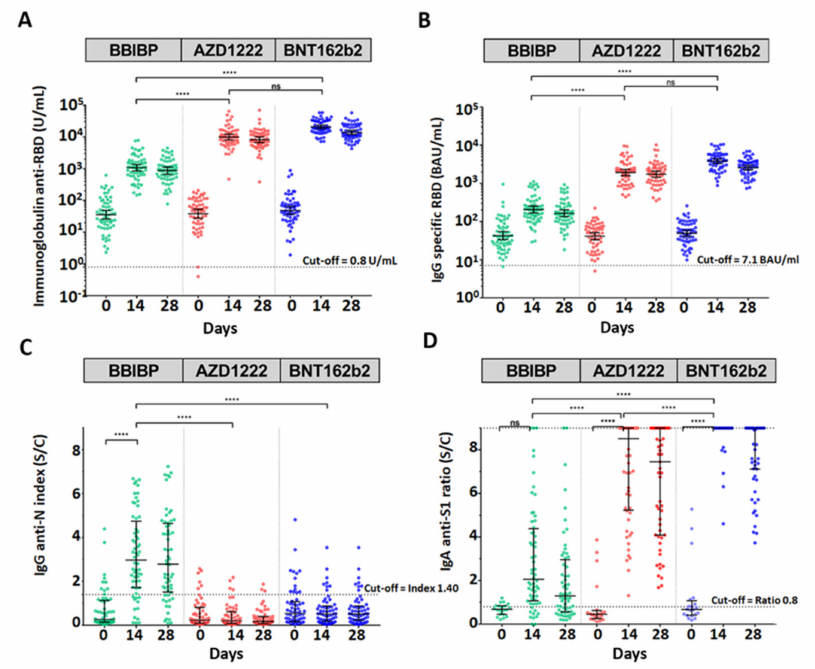
Figure 2. Antibody responses against SARS-CoV-2 assay. The circulating total immunoglobulin anti-RBD of SARS-CoV-2 (U/mL) ( A ). The circulating IgG-specific RBD of SARS-CoV-2 (BAU/mL) ( B ). IgG anti-N of SARS-CoV-2 index (S/C) ( C ). IgA anti-S1 of SARS-CoV-2 ratio (S/C) ( D ). The serum samples were obtained from participants who received two completed doses of the inactivated vaccine, CoronaVac; followed by the inactivated vaccine, BBIBP (green); the viral vector vaccine, AZD1222 (red); or the mRNA vaccine, BNT162b2 (blue), at 3–4 months after the first dose. Lines represent GMTs (95% CI); ns indicates no statistical difference; p < 0.0001